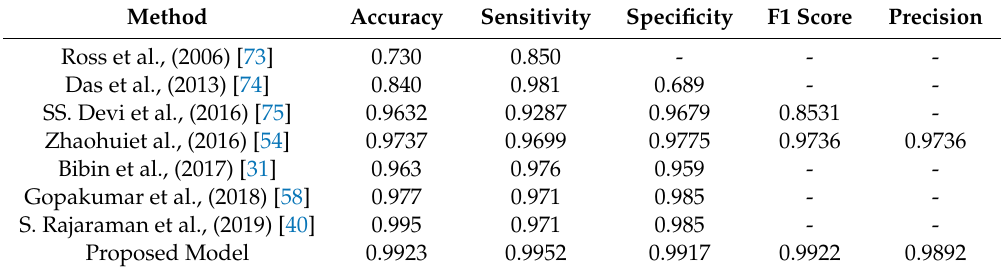
Table 7. Performance comparison.